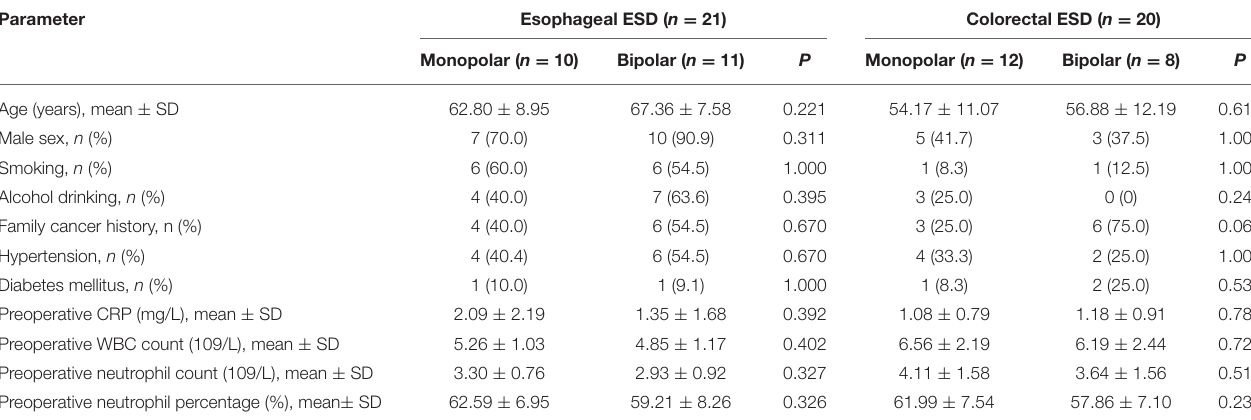
TABLE 2 | The characteristics of patients underwent ESD in monopolar and bipolar groups. Parameter